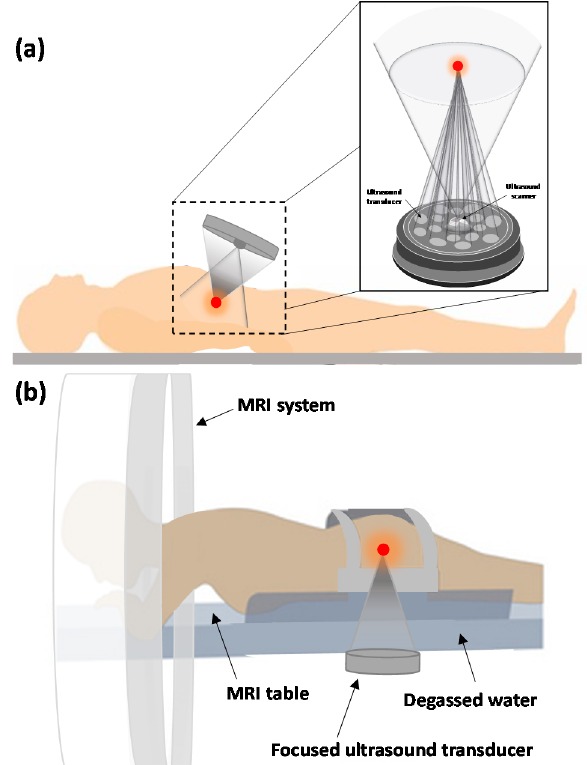
Figure 3. Schematic of ( a ) the structure of an extracorporeal high intensity focused ultrasound (HIFU) transducer, including both imaging and therapy probes, depicting an ultrasound-guided technique on a patient and ( b ) magnetic resonance-guided extracorporeal focused ultrasound system treatment technique.